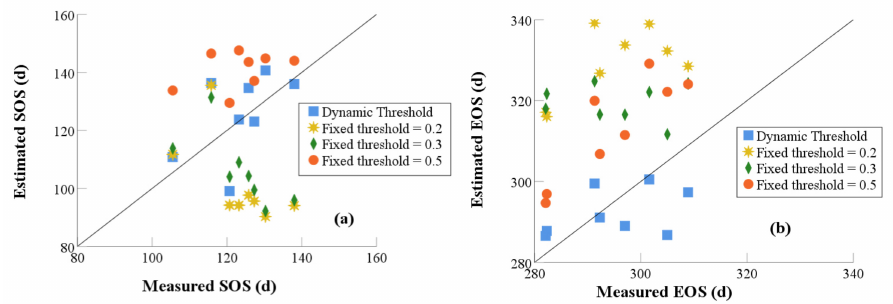
Figure 5. The scattering plot between estimated and measured value. ( a ) is the SOS and ( b ) is the EOS (black line is y = x